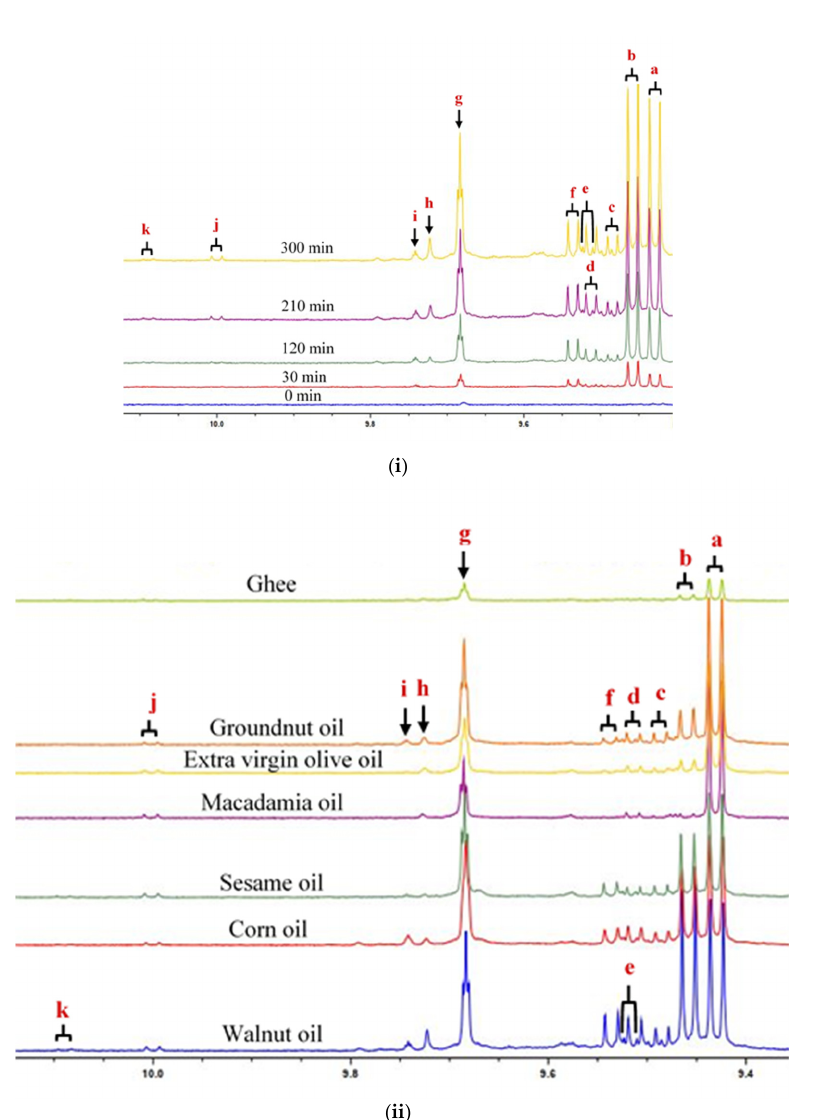
Figure 3. 1 H NMR profiles showing expanded aldehyde-CHO function (9.40–10.20) ppm regions of ( i ) walnut oil thermally stressed for increasing durations and ( ii ) all culinary oils thermally stressed for an extreme 300 min period. Letter assignments of resonances correspond to those provided in Table 3.